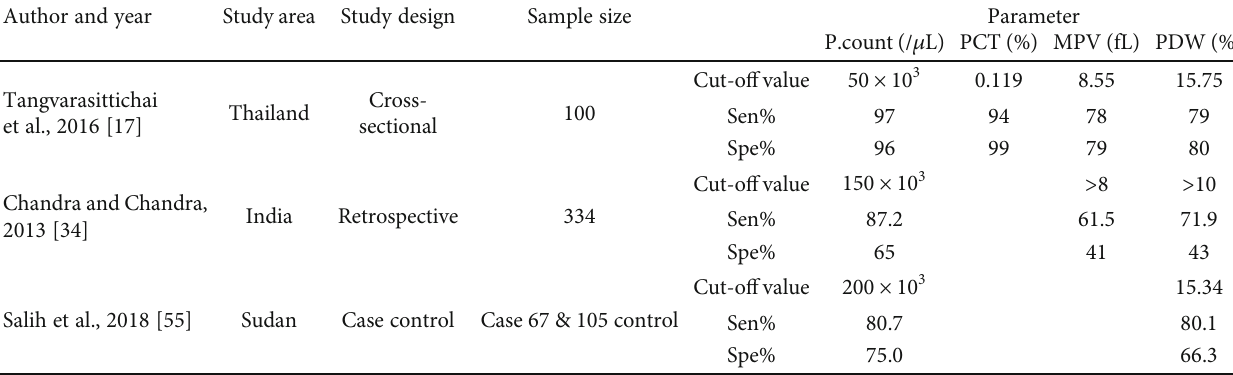
Table 1: Platelet count and platelet indices for diagnosis in patients with malaria